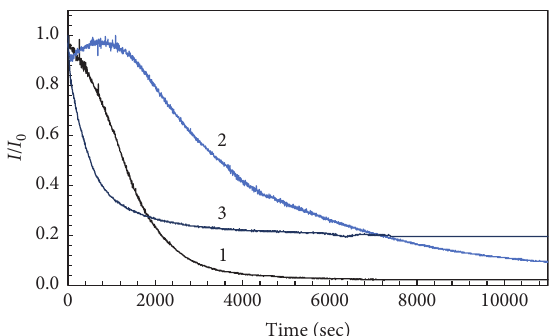
Figure 2: Normalized chronoamperometric curves of the electro- chemical scaling process in tap water at 25 ° C in the presence of the radish cake extract:1, no extract; 2, 1mL/L extract; 3, 10mL/L extract.